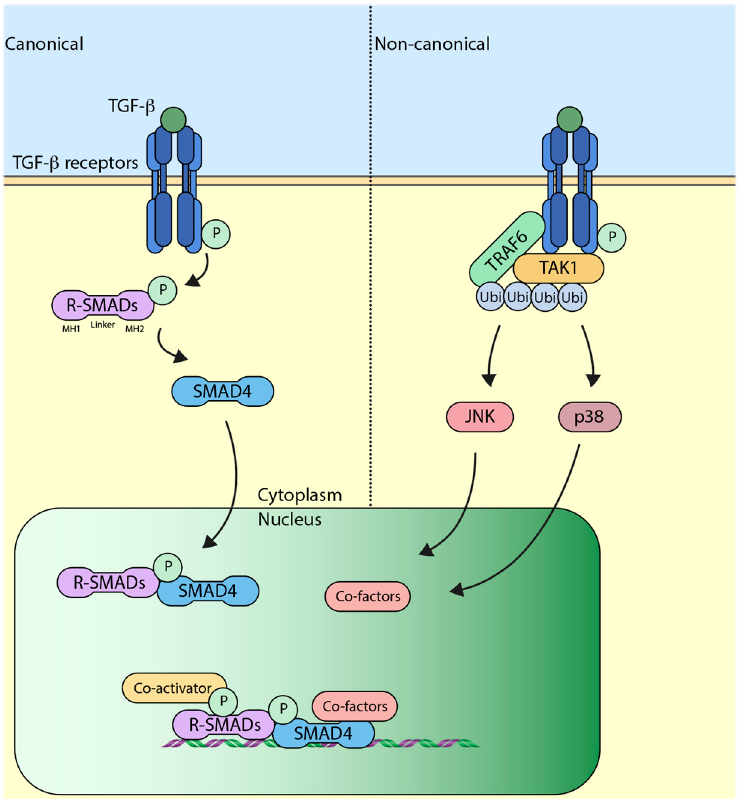
Figure 1. Schematic representation of the transforming growth factor- β (TGF- β ) pathway. Left-hand side of the dotted line represents canonical pathway, wherein signaling is transmitted by a SMAD (sma and mothers against decapentaplegic)-dependent mechanism, whereas the right-hand side represents non-canonical pathway, which is SMAD-independent. R-SMADs: Regulatory elements SMADs, Ubi: Ubiquitin, JNK: c-Jun N-terminal kinase, TAK1: TGF- β associated kinase 1, TRAF6: TNF receptor-associated factor 6, P: Phosphate group.